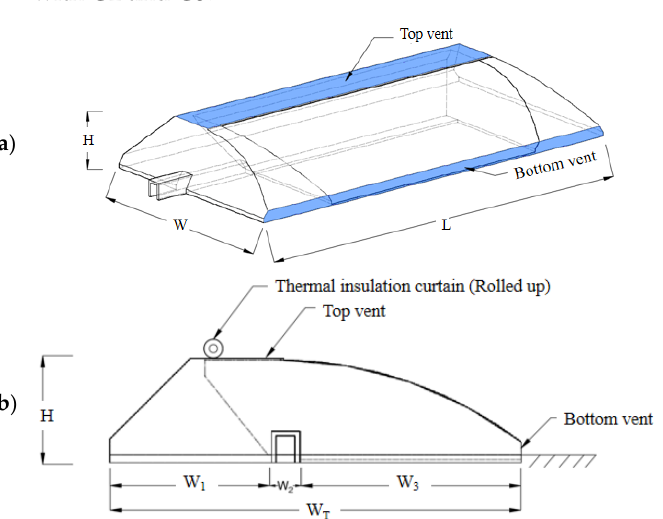
Figure 1. SSG structure: ( a ) Overview, L is total length, W is total width, H is total height; ( b ) Side view, W1 is bottom width of the back wall, W2 is pavement width, W3 is planting area width, WT is total width, H is total height.